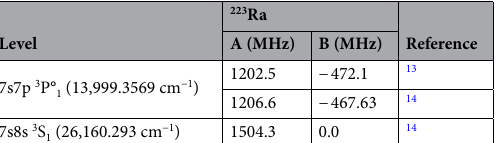
Table 1. A table of hyperfine structure constants of 223 Ra isotope energy levels.